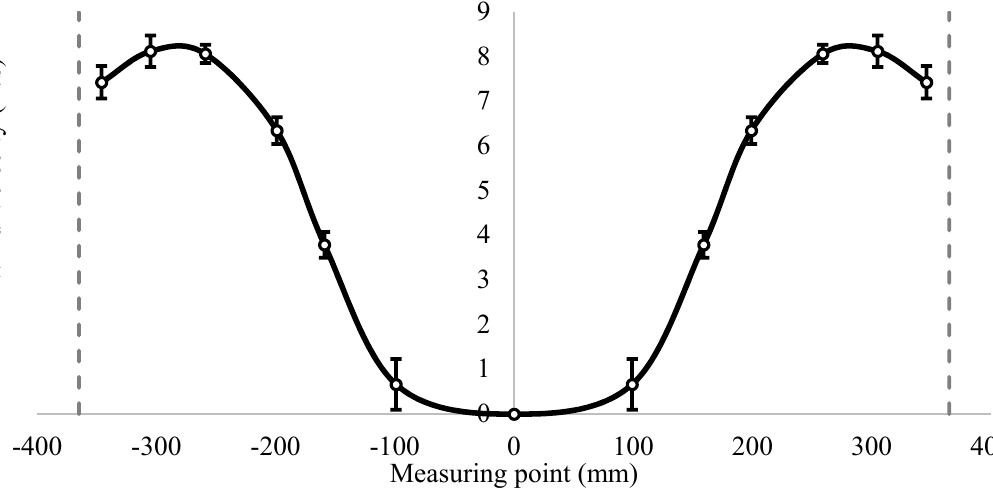
Figure 8. Mean wind velocity of at the outlet of the cooling tower